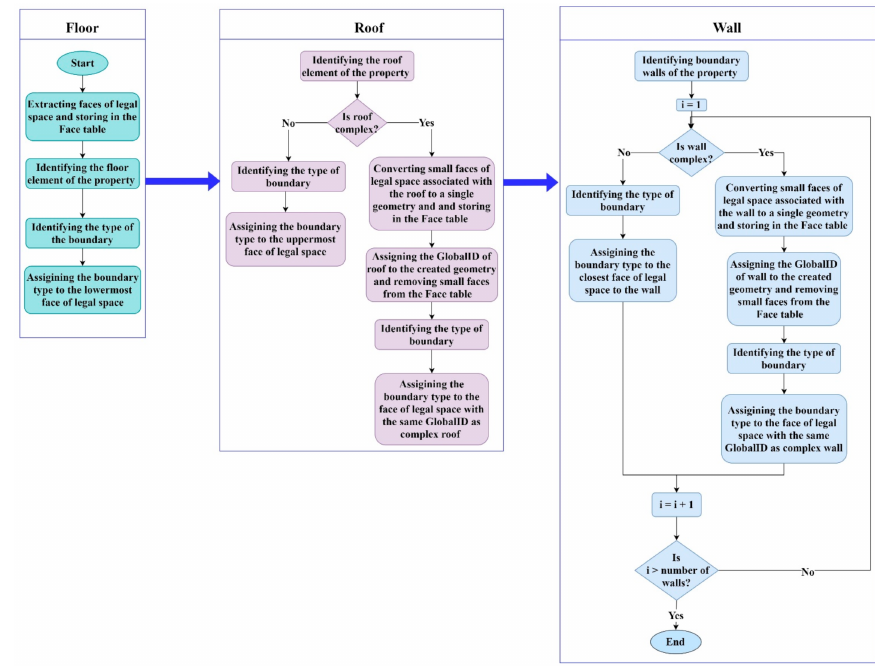
Figure 1. The proposed methodology for boundary identification analysis.